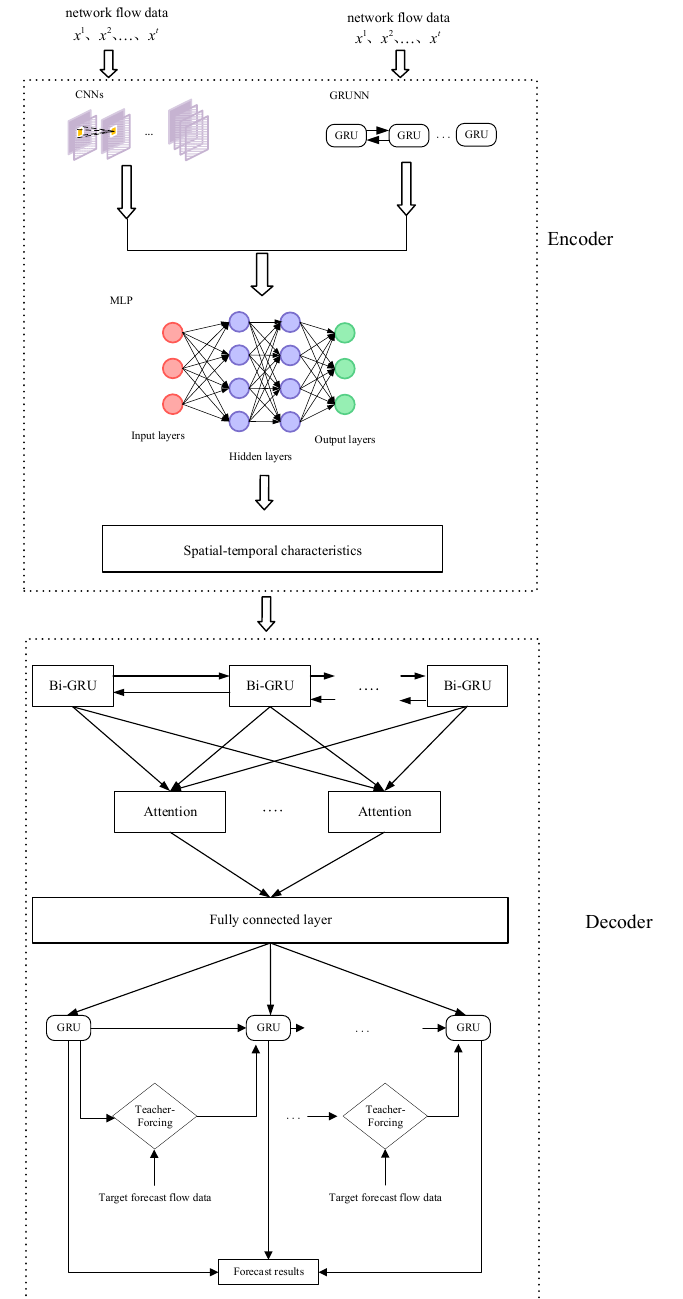
Figure 7. Overall architecture of multilayer perceptron integrated